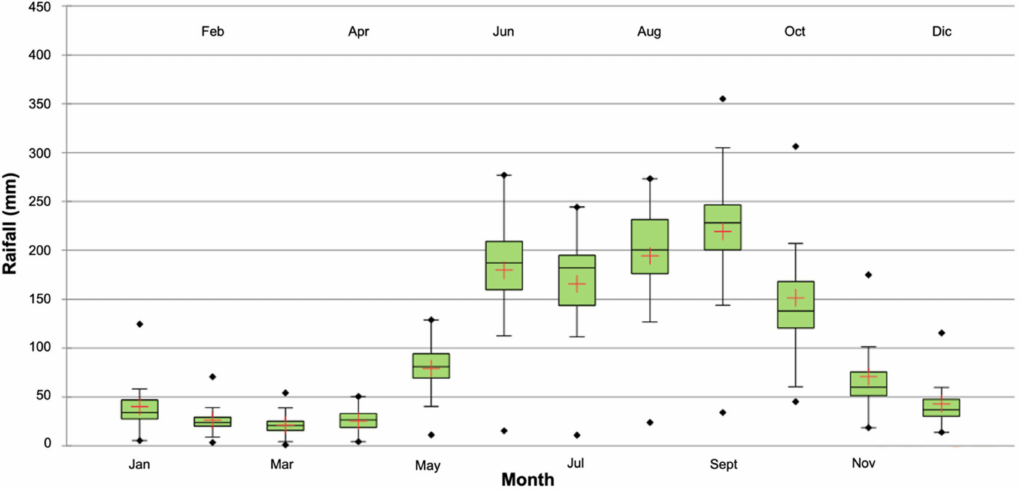
Figure 2. Shows the average values, 95% confidence intervals and average annual precipitation (1216.3 ± 110 mm). According to these data, September is the rainiest month (219.00 ± 40 mm), and March is the least rainy month (21.12 ± 10 mm), squares represent minimum and maximum values for each month.